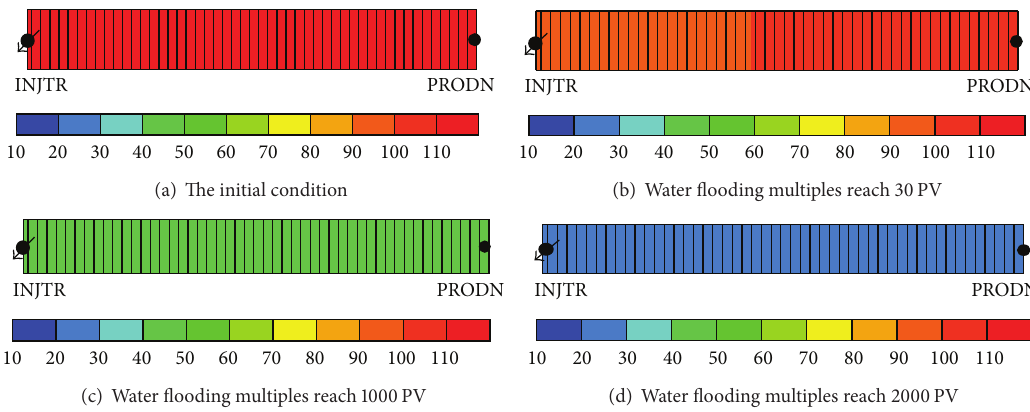
Figure 9: Adsorption contents of clay under the condition of different water flooding multiples (gmole/m 3 ).